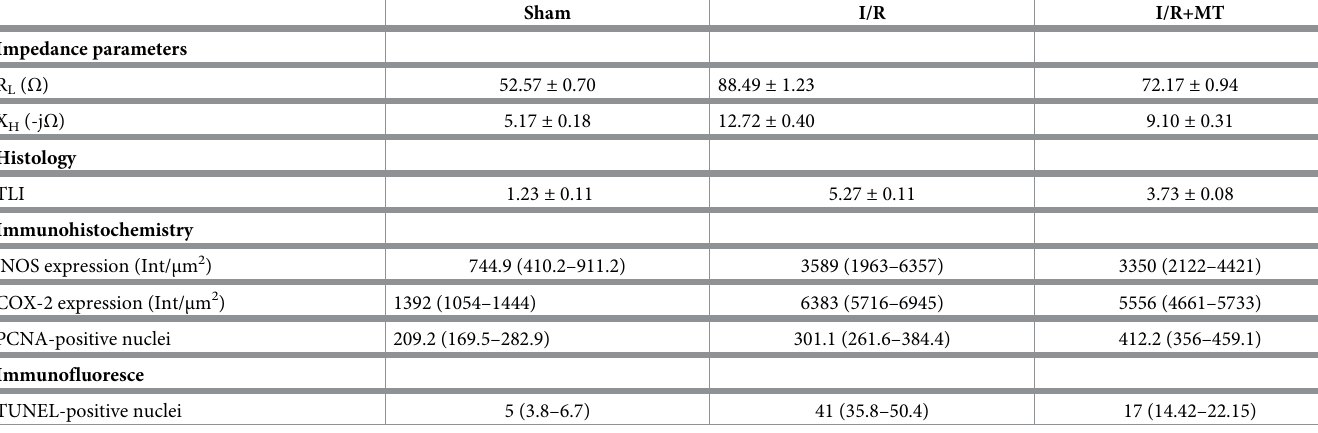
Table 2. Effect of MT treatment on impedance parameters (R L and X H ), gastric mucosa damage and the expression of inflammatory process markers, proliferation, and apoptosis.